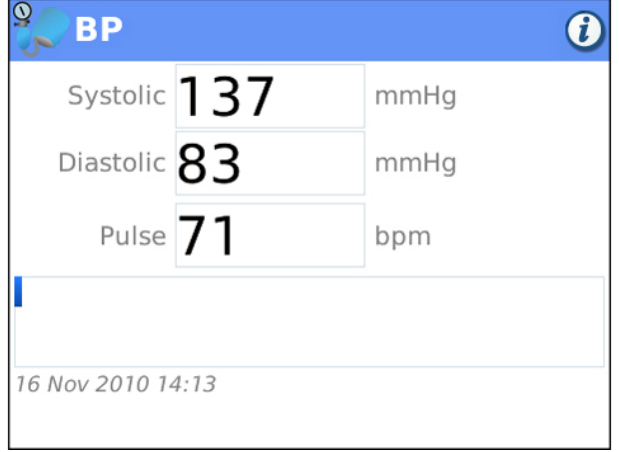
Figure 9. Blood Pressure Tracker: Clients enter blood pressure including systolic, diastolic, and heart rate and are able to comment on the